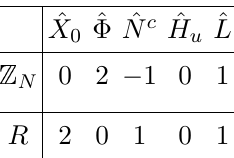
Table 1 . The lepton ^ L , Higgs ^ H u , CP conjugated right-handed neutrino ^ N c , auxiliary ^ X 0 and in(cid:13)aton (Majoron) ^(cid:8) super(cid:12)elds of the model, and how they transform under the symmetries Z N and U(1) R